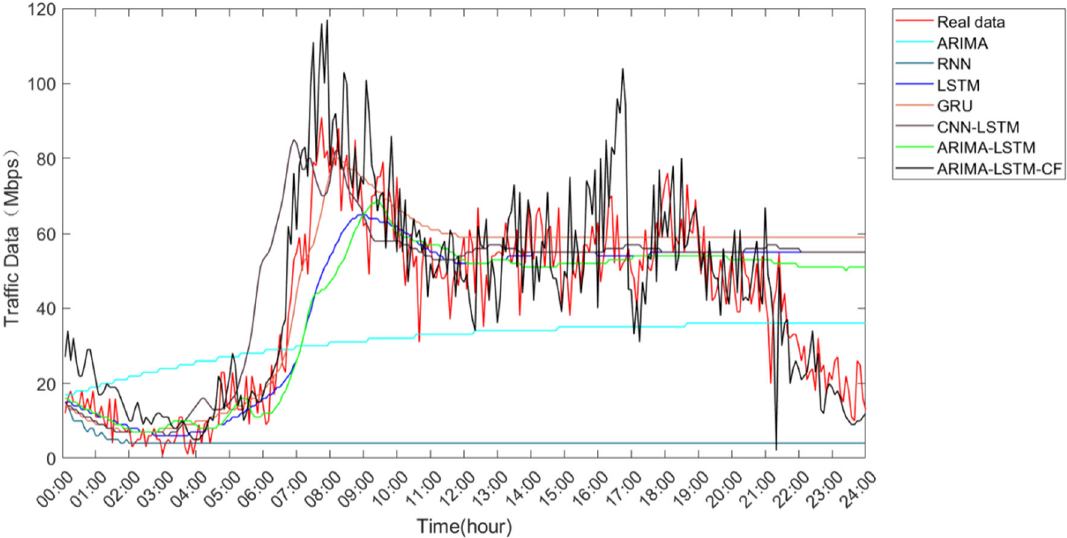
Fig. 12 Single-day traffic data prediction results of different prediction models on another